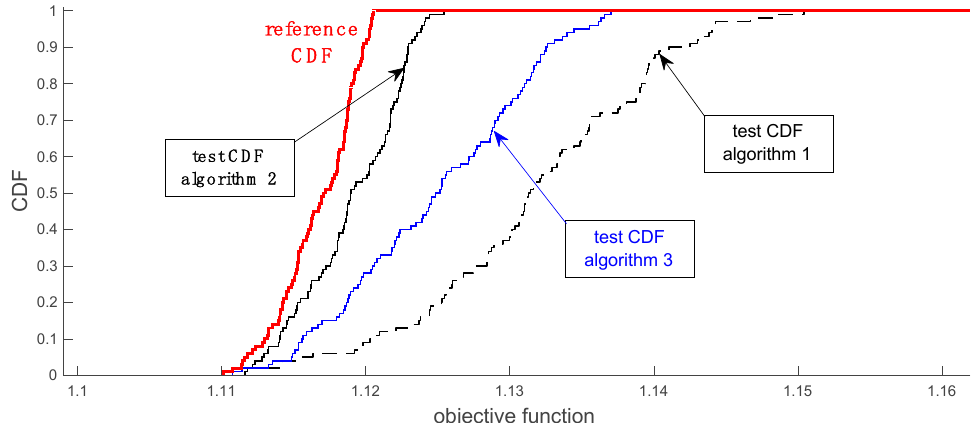
Figure 4. Determination of the reference CDF for the calculation of the Optimization Performance Indicator that is based on Stochastic Dominance ( OPISD ) indicator without knowing the global optimum.